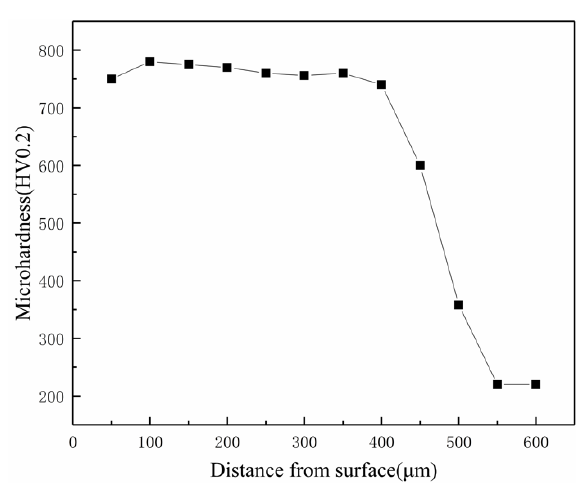
Figure 6. Microhardness curve of the cross-section in a bionic unit.